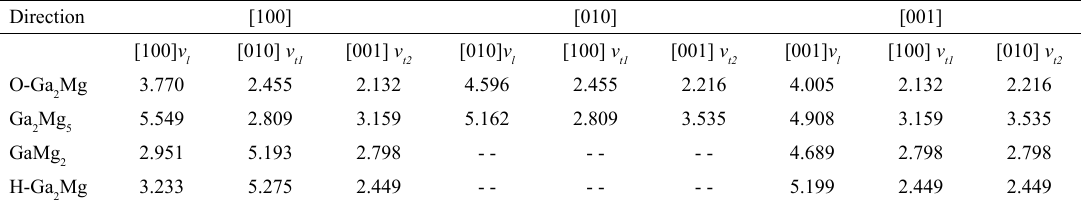
Mg and GaMg compounds. The unit of velocity (ν) is km/s. Table 6. The anisotropic sound velocities of tetragonal Ga 5 2 Direction [100] [001] [110] [100] ν [001] ν [010] ν [001] ν [100] ν [010] ν [110] ν [001] ν l t1 t2 l t1 t2 l t1 Ga Mg 5 2 GaMg Mg, Ga Mg and hexagonal GaMg , H-Ga Mg compounds. The unit Table 7. The anisotropic sound velocities of orthorhombic O-Ga 2 2 5 2 2 of velocity (ν) is km/s. Direction [100] [010] [001] [100] ν [010] ν [001] ν [010] ν [100] ν [001] ν [001] ν [100] ν [010] ν l t1 t2 l t1 t2 l t1 t2 O-Ga 2